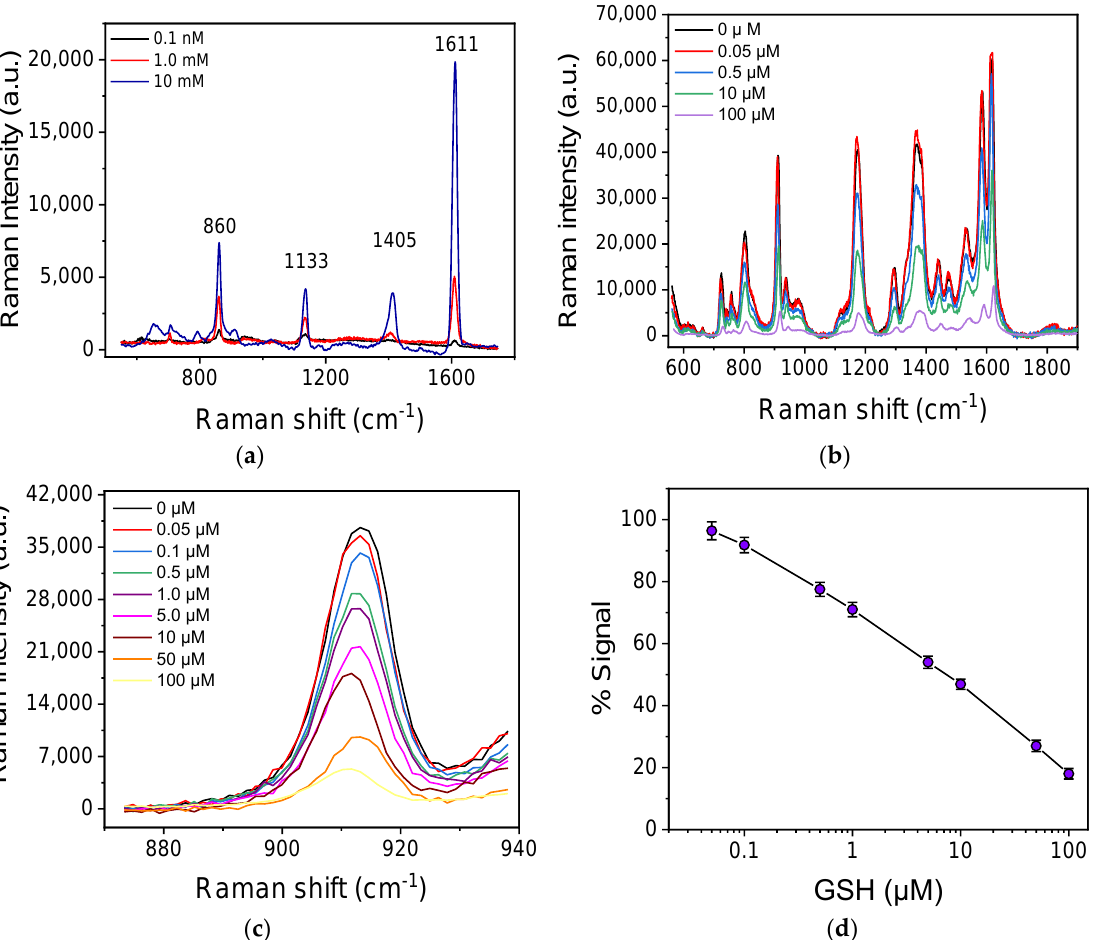
Figure 5. ( a ) Raman spectra from SiNWs/Ag nanoparticle substrates incubated with aqueous GSH solutions of 0.1 (black line), 1.0 (red line), and 10 mM (blue line) concentrations at 785 nm laser excitation. ( b ) Raman spectra from SiNWs/Ag nanoparticles substrates modified with CV prior to the incubation with GSH solutions of 0 (black line), 0.05 (red line), 0.5 (blue line), 10 (green line), and 100 μ M (violet line) concentrations at 532 nm laser excitation. ( c ) Partial Raman spectra including the peak at 915 cm −1 obtained from SiNWs/Ag nanoparticle substrates modified with CV prior to the incubation with GSH solutions with concentrations ranging from 0 to 100 μΜ . ( d ) Typical calibration curve of GSH. Each point is the mean of measurements received from 5 substrates (3 different spots per substrate) ± SD.